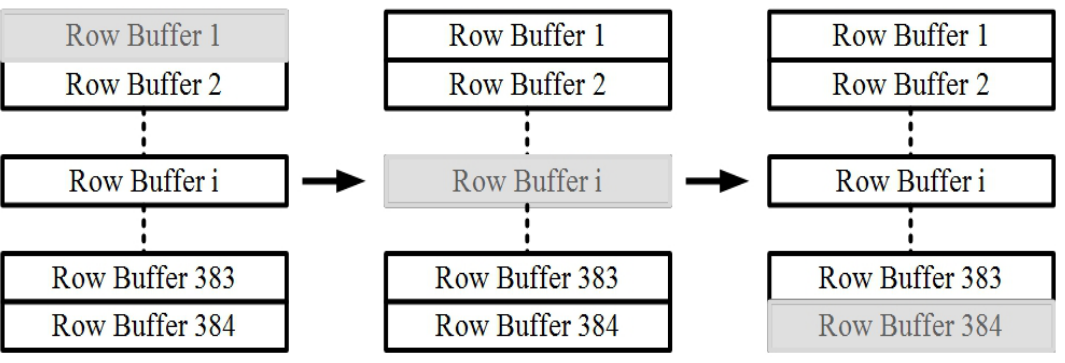
Figure 6. Differential integrator